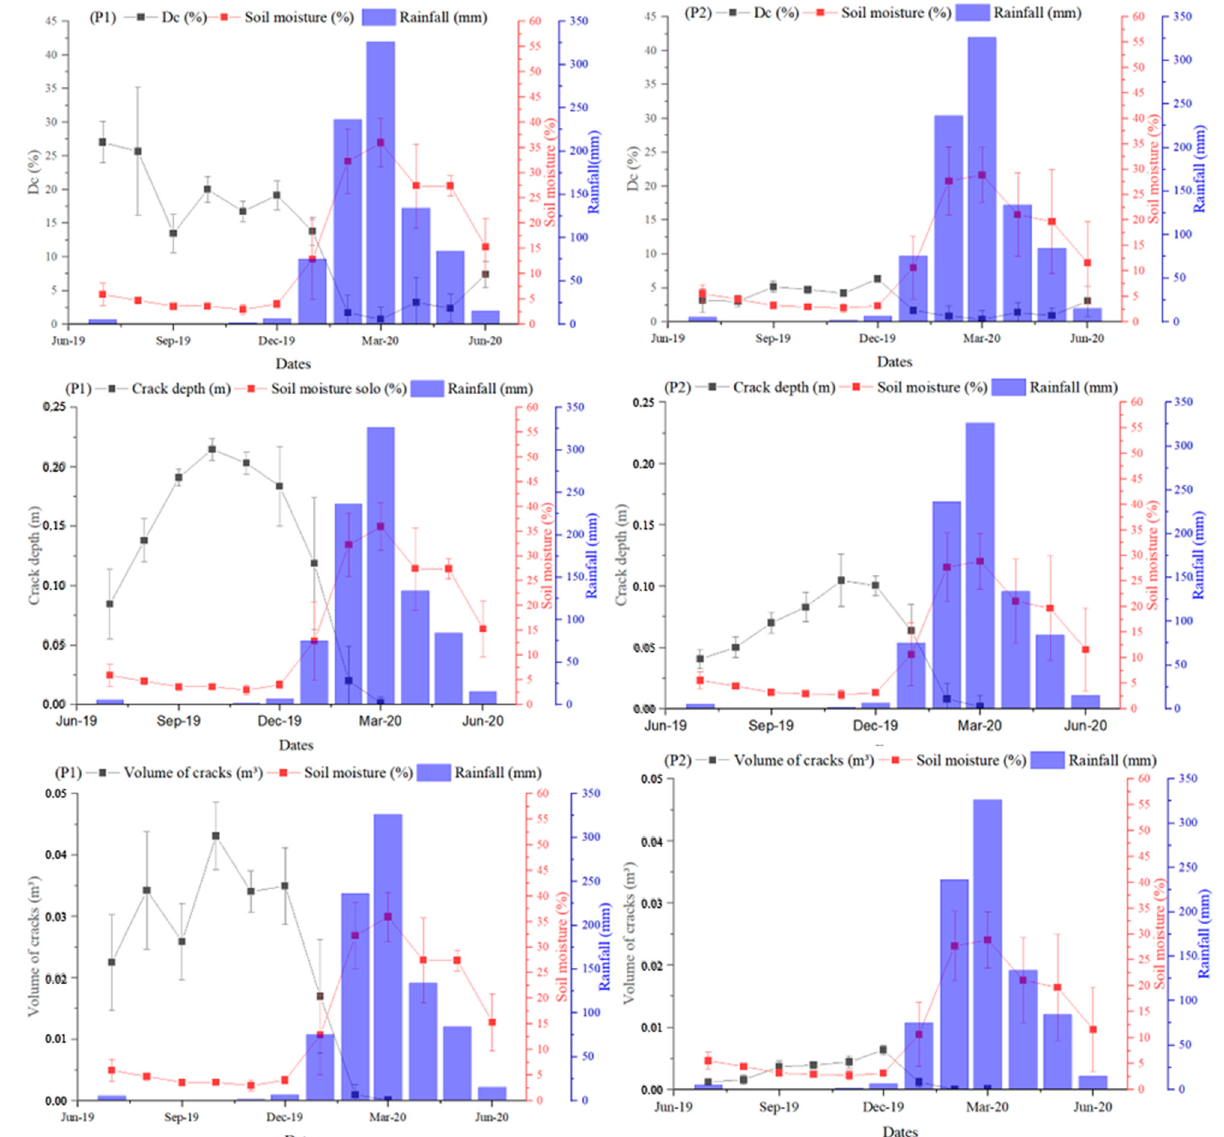
Figure 8. CL cluster plots P1 and P2—monthly Dc, area, depth, soil moisture and rainfall.